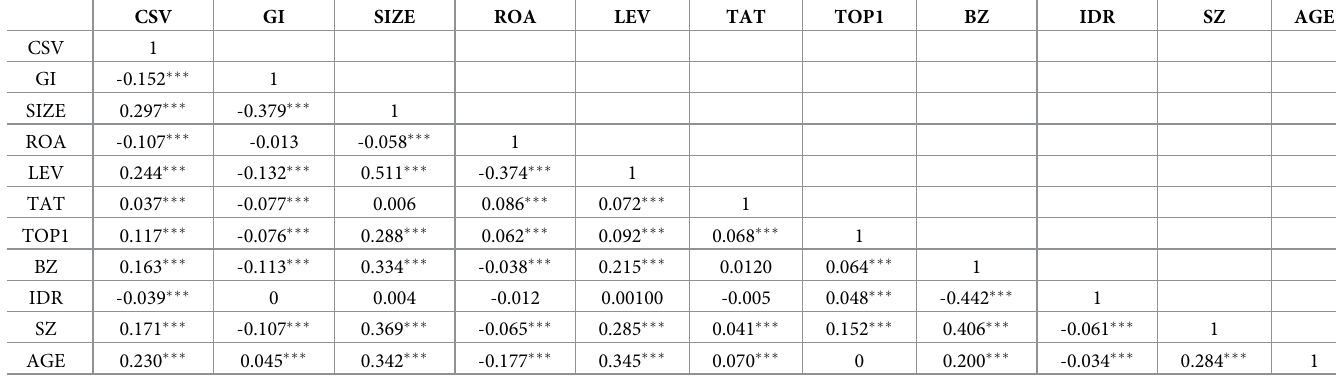
Table 5. Correlation